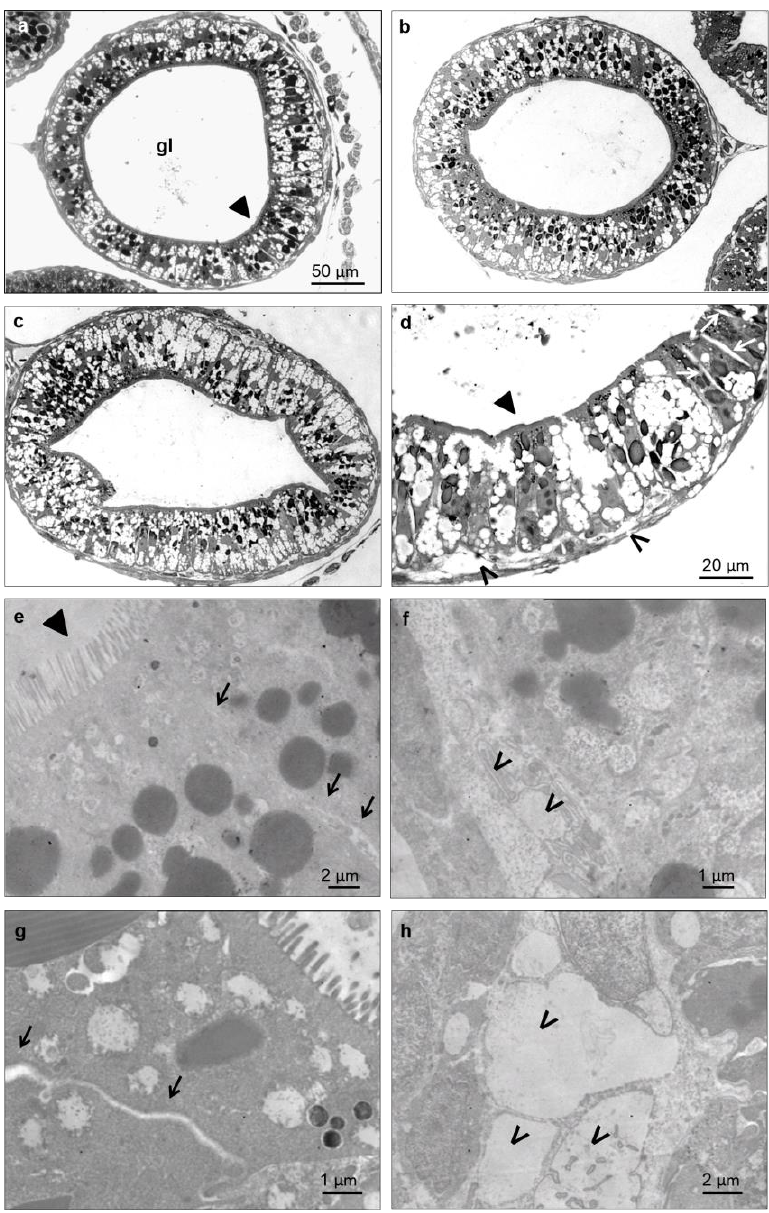
Figure 7. Light ( a – d ) and electron microscopy ( e – h ) imaging of the X. laevis small intestine. Transversal sections at the level of an intestinal loop of a control (a), bZnO (b) and sZnO (c,d) exposed embryos. Magnification of the sZnO intestinal loop (d) shows the swelling of paracellular spaces between cells (empty arrow) and detachment in some regions of epithelial cells from basal lamina (*). These damages are more evident in the detail of the junctional complex between two enterocytes (g) (black arrow) and of the basal portion (h) (*) of sZnO-exposed embryos in comparison to the control (e) (black arrow) and (f) (*). ► = brush border; gl = gut